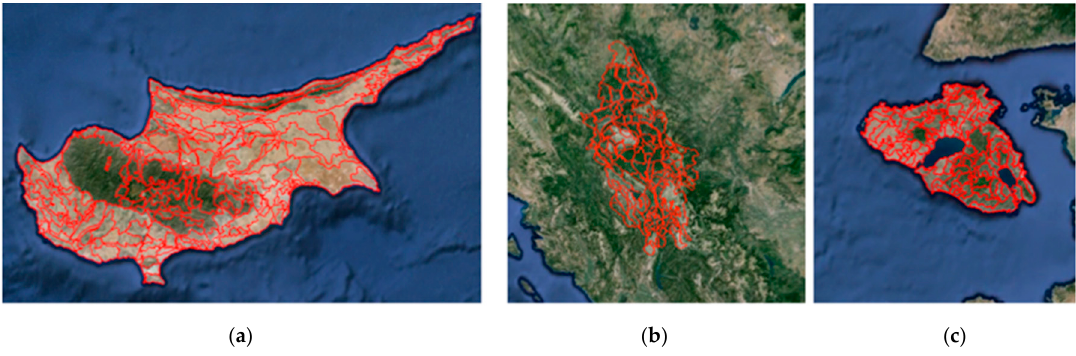
Figure 2. Risk assessment model study areas in the partner countries. ( a ) Cyprus Area: 9251 km 2 ; ( b ) Greece—Epirus Area: 6790 km 2 ; ( c ) Greece—Lesvos Area: 1632 km 2 .